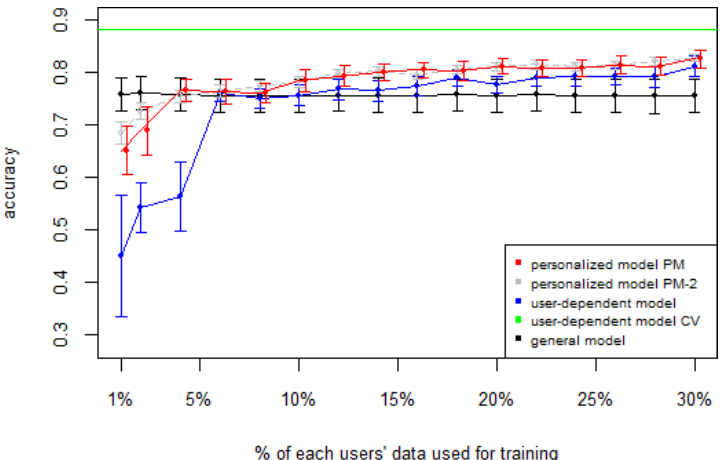
Figure 5. D5: Opportunity dataset. PM: Personalized Model; CV: Cross Validated.